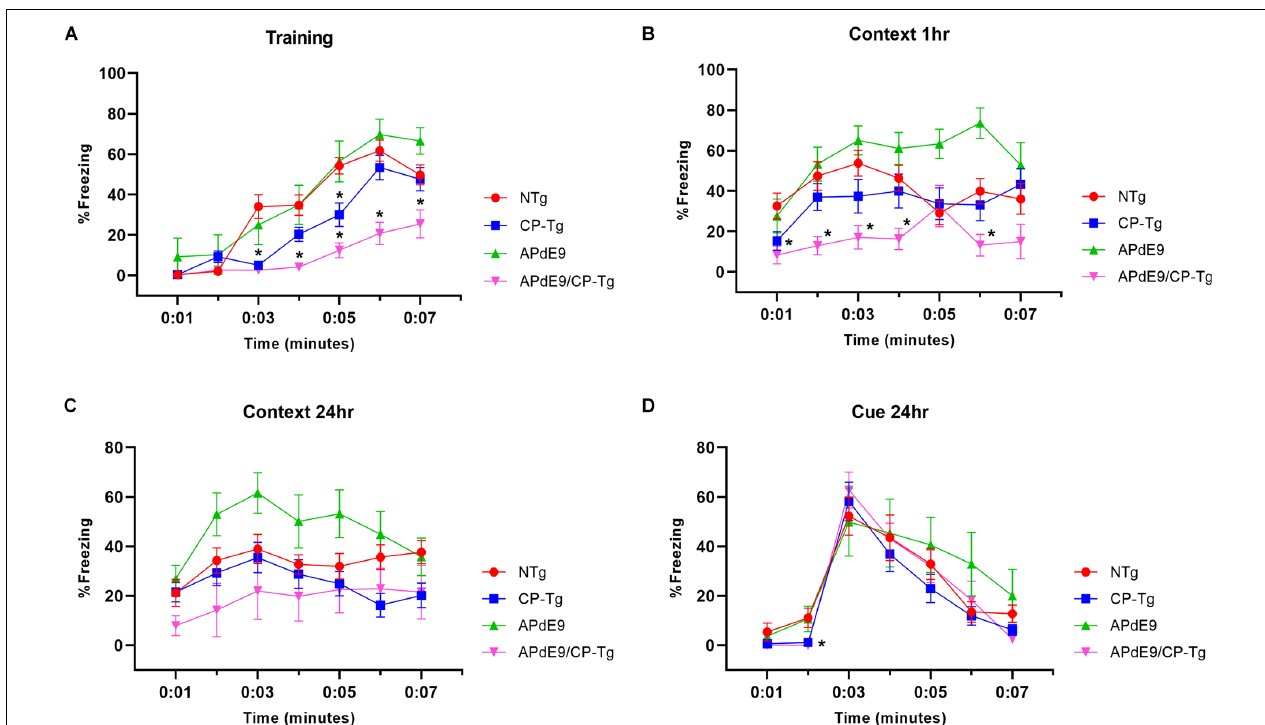
FIGURE 4 | APdE9/CP-Tg mice exhibit impaired learning. (A) PGIS overexpression significantly decreased the percentage freezing time after the first and second shock (shock given at 2nd and 4th min) of the training trial ( p < 0.05) while the combination of A β and prostacyclin further decreased freezing times during training. (B) APdE9 mice exhibited an enhanced short-term memory response while APdE9/CP-Tg mice exhibited a depressed short-term memory response. (C) CP-Tg and APdE9/CP-Tg mice exhibited worse performance in a contextual test of long-term memory compared to APdE9 mice. (D) CP-Tg and APdE9/CP-Tg mice